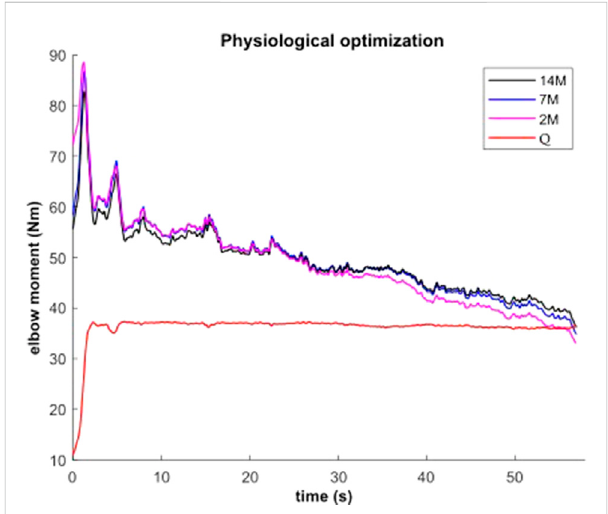
FIGURE 7 Available maximal elbow fl exion moment evolution during static effort using physiological optimization and three muscle models (14M incorporates 2 fi ber type groups for 7 muscles; 7M does not consider fi ber type; and 2M groups the fl exors in one actuator and the extensors in